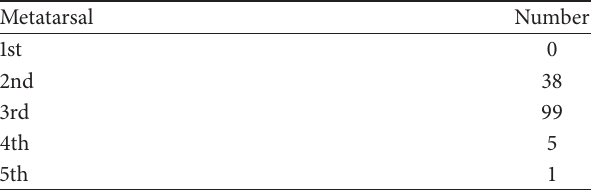
Table 2: The distribution of metatarsal